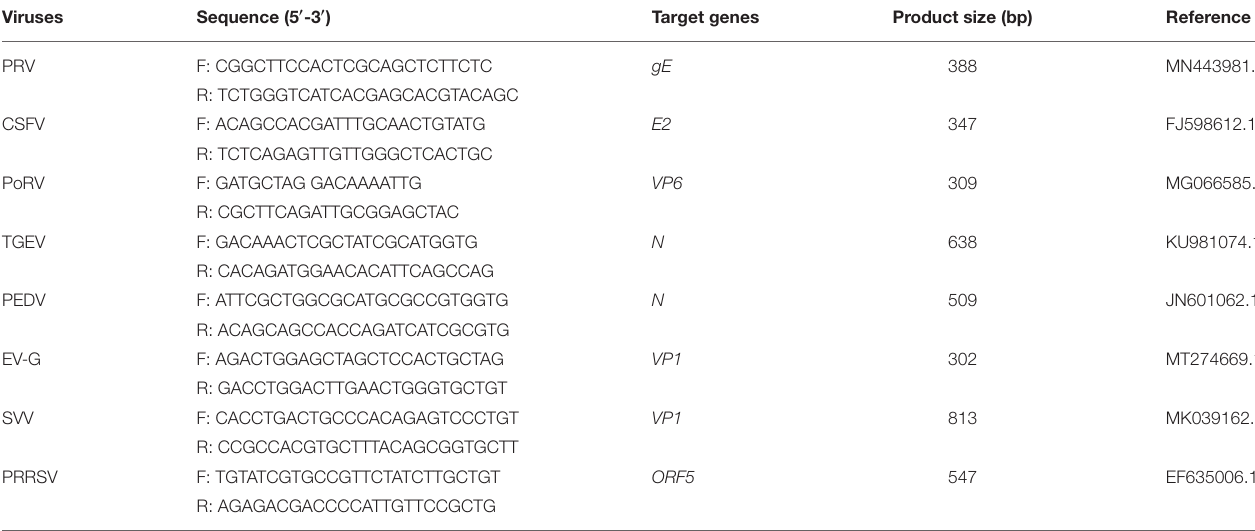
TABLE 2 | Detection primers used for specificity analysis. Viruses Sequence (5 ′ -3 ′